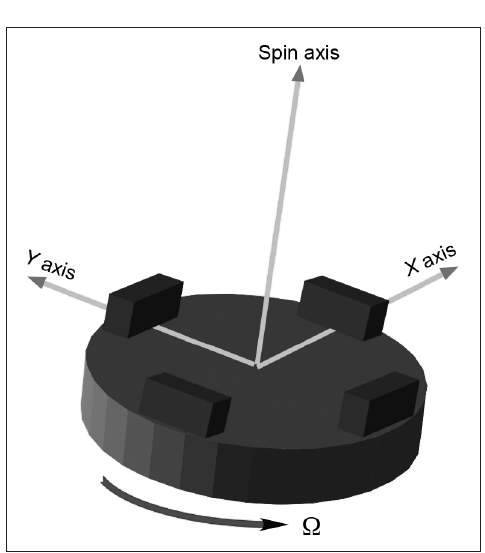
Fig. 2. Basic scheme of a GGI (Gravity Gradiometer Instrument): two opposite matched pairs of linear ac- celerometers sit on a spinning platform. The gravity gradient signal is given by a linear combination of the accelerometer outputs at twice the spinning